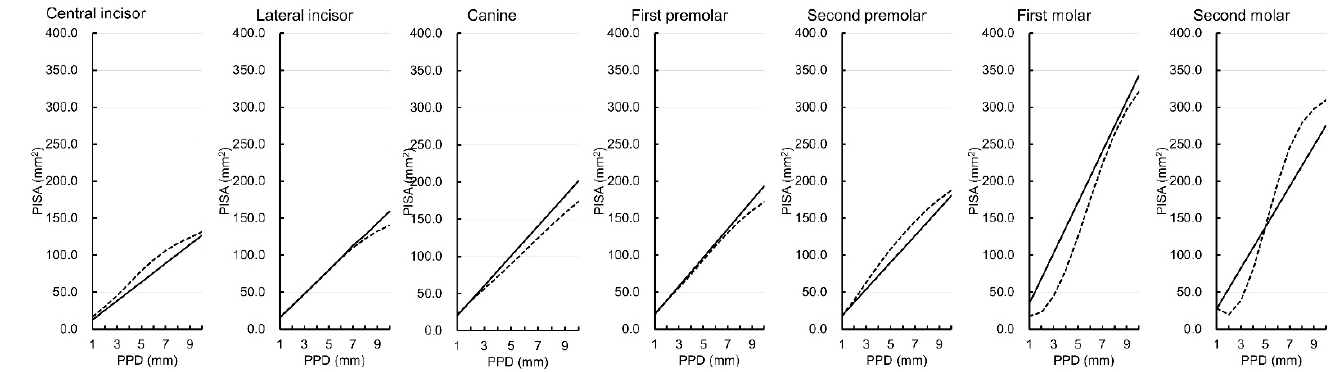
Figure 2. Simulated periodontal epithelial surface area (PISA) for probing pocket depths (PPDs) of 1 to 10 mm with bleeding on probing positivity at all six sites around the tooth in the Japanese version (solid lines) and original version (dotted lines) [1] for each tooth type in the mandible.